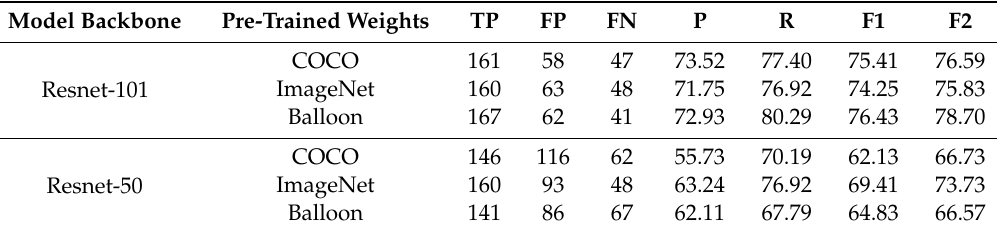
Table 4. Results from testing on ETIS-Larib polyp data.